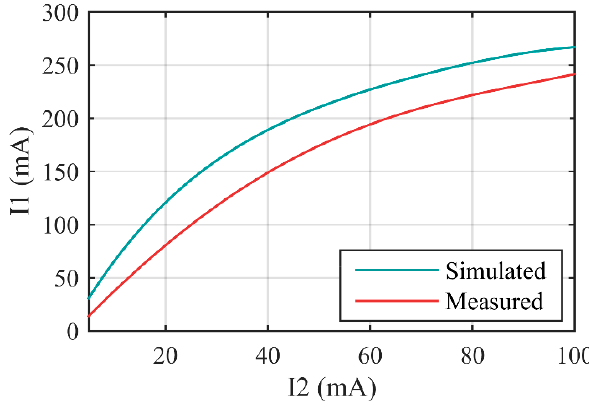
Figure 8. L 1 ’s control current (I 1 ) as function of L 2 ’s control current (I 2 ).